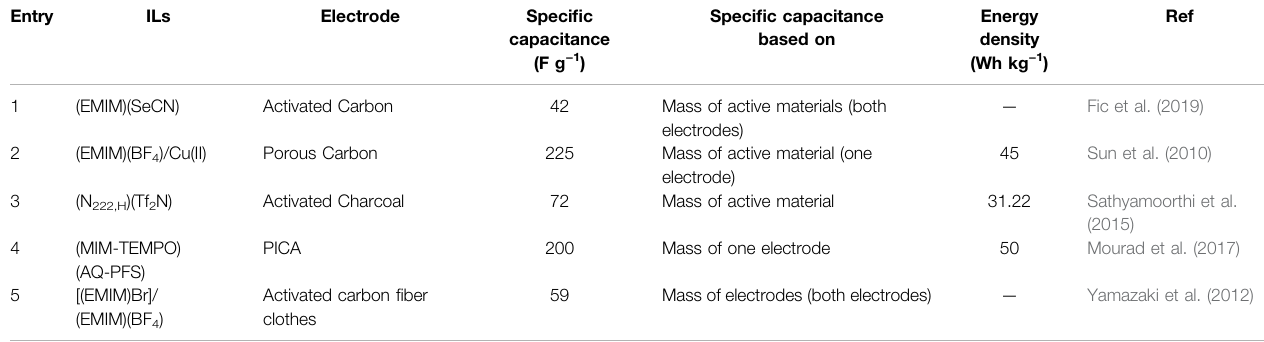
TABLE 3 | Summary of SC performance of redox-active